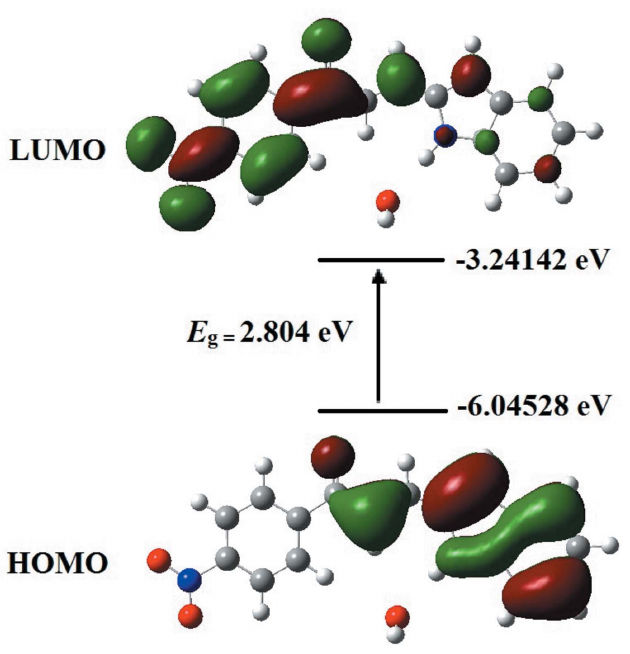
Figure 7 Molecular orbitals showing electronic transition between HOMO– LUMO of the title compound.